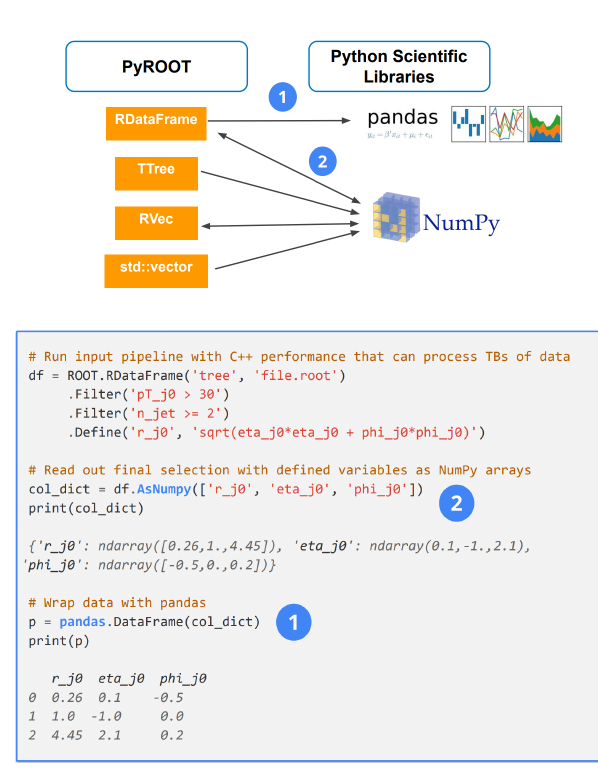
Figure 5: Overview over the interoperability features provided by